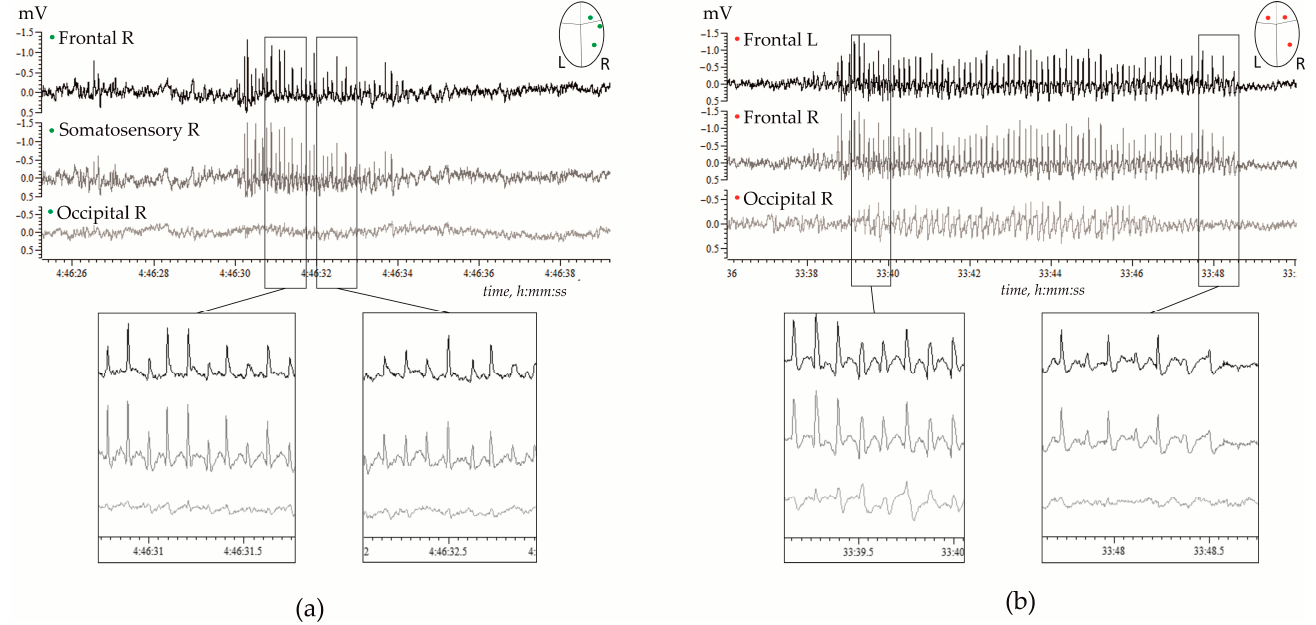
Figure 1. Examples of spontaneous spike-wave discharges (SWDs) in electrocorticograms recorded in freely moving adult WAG/Rij rats; ( a )—11 months old subject, and ( b )—7 months old subject. ( a ) Regular high-voltage 8–10 Hz SWDs were expressed in the right hemisphere (R) over the frontal and parietal (somatosensory) cortical areas, but were hardly seen over the occipital area. ( b ) High-voltage 8–10 Hz SWDs were bilaterally synchronized, and were present in the left (L) and right frontal cortical areas, and were seen in the occipital cortex.